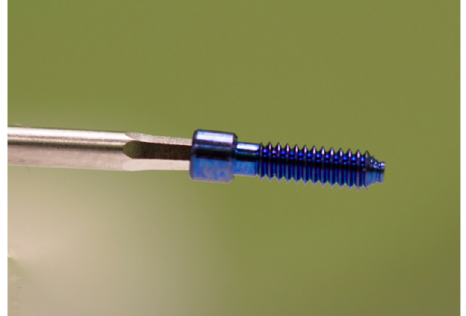
Figure 1. Original grade IV titanium prosthetic screw.